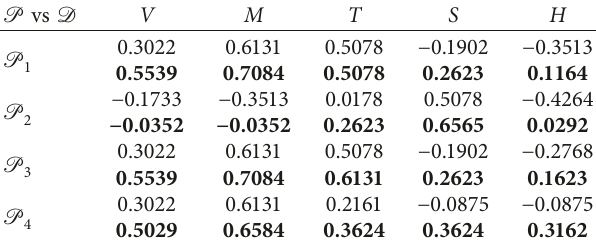
Figure 4: P vs diseases. 4 Table 5: Comparative